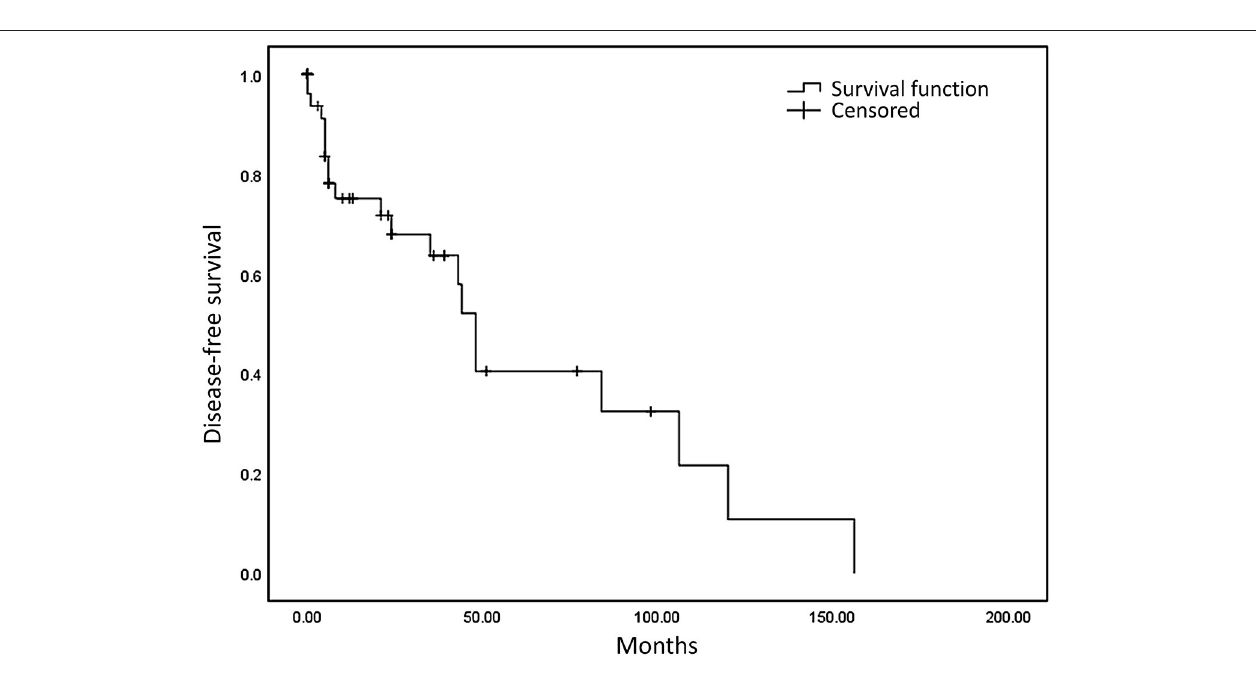
was IA-100.0%, IB-60.0%, IIIA-0.0%, IIIB-0.0%, and IV-0.0% ( P < 0.001) ( Table 3 ).